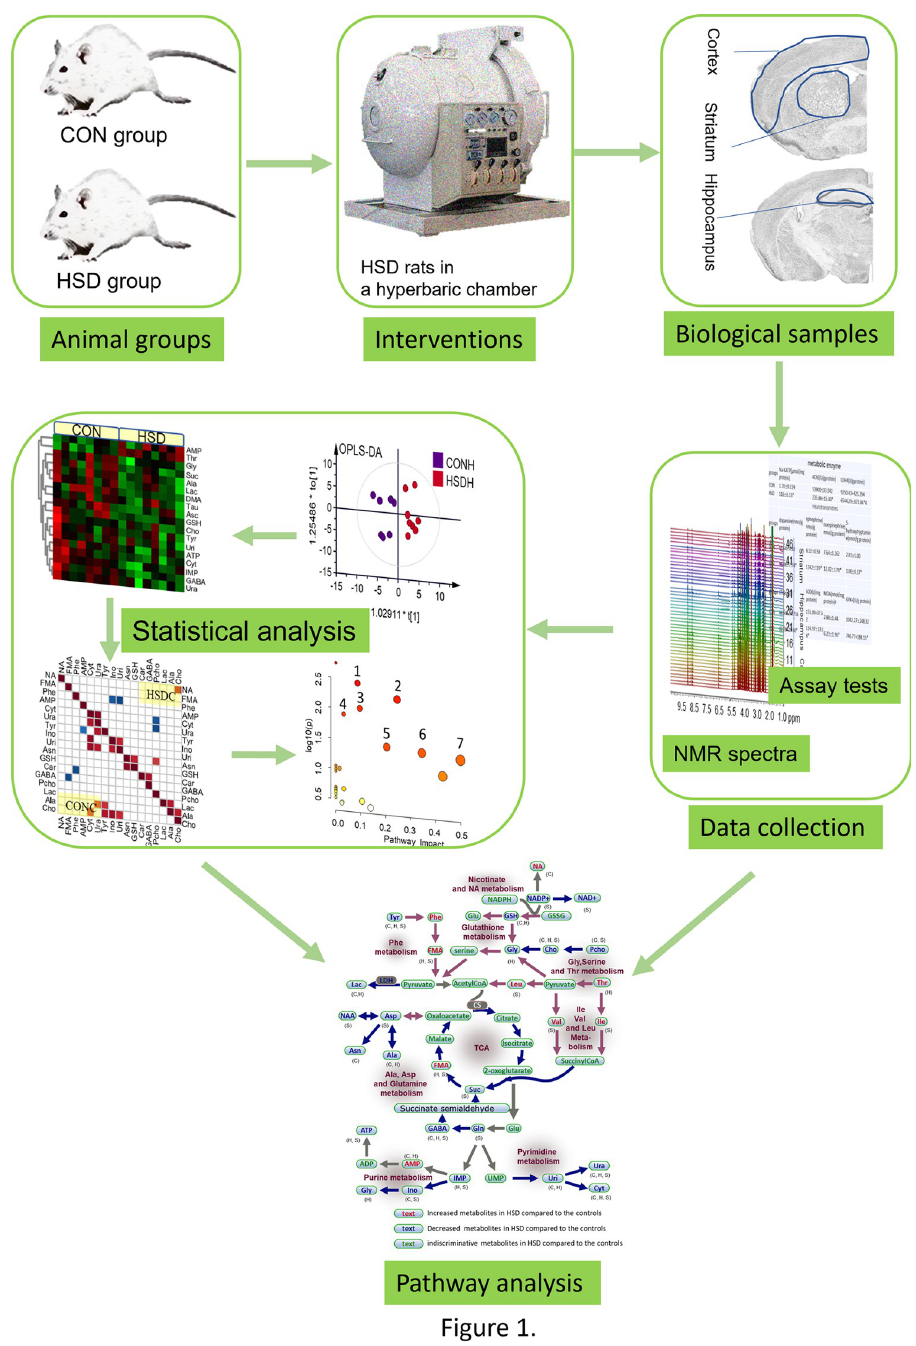
Fig 1. Schematic experimental design of the present